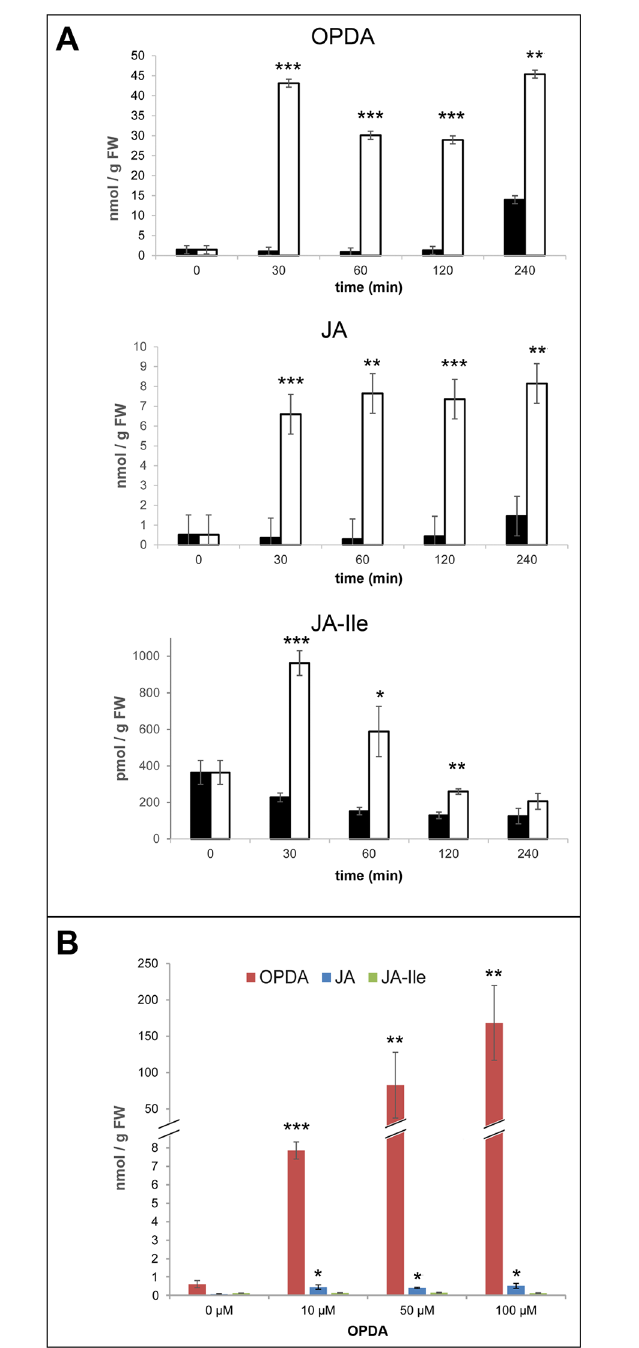
Fig 1. Conversion of 12-oxophytodienoic acid (OPDA) in leaves of Arabidopsis thaliana ecotype WS (wild type, A) and opr3 (B). A, Leaves of 5-week-old WS plants grown under short-day conditions were floated on water (control, black bars) or on 50 μ M OPDA for the time periods indicated. Levels of OPDA, jasmonic acid (JA) and JA-Ile are presented. B, Leaves of 5-week-old opr3 plants grown under short-day conditions were floated on solutions containing different concentrations of OPDA for 30 min. Levels of OPDA (red bars), JA (blue bars) and JA-Ile (green bars) are presented. Contents of OPDA, JA and JA-Ile were determined by LC-MS according to [30]. Each value is represented by the mean of three independent biological replicates ± SD. Treatments and controls were pairwise compared by the Student ’ s t-test, * p (cid:1) 0.05, ** p (cid:1) 0.01, *** p (cid:1)